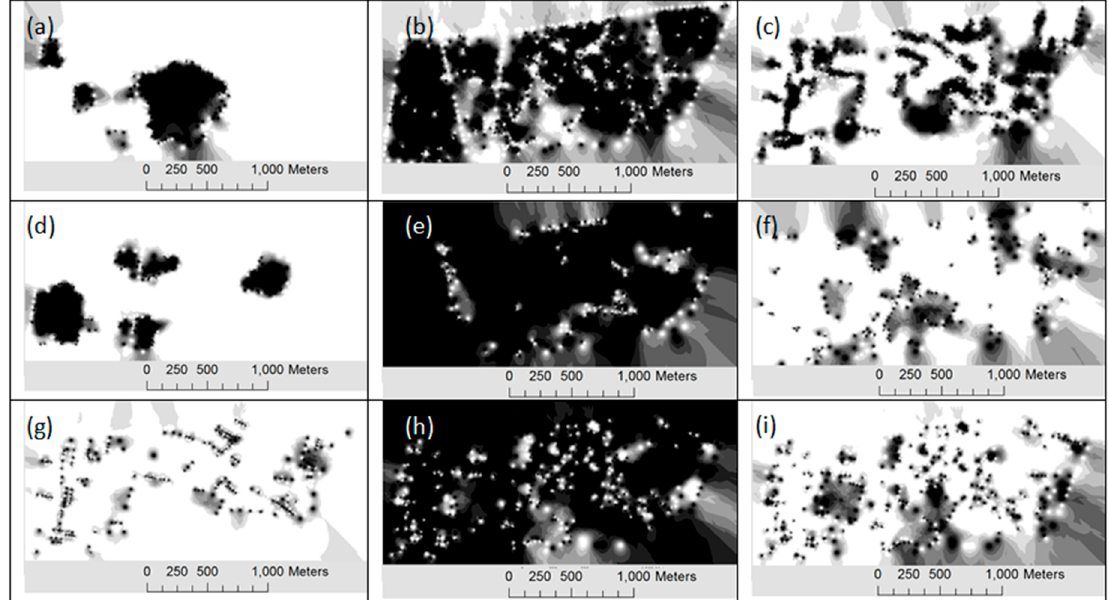
Figure 5. Parameters that denote legibility along the streets, that is, ( a ) singularity; ( b ) form simplicity; ( c ) continuity; ( d ) dominance; ( e ) clarity of joints; ( f ) directional differentiation; ( g ) visual scopes (determined by edges); ( h ) visual scopes (determined by paths); and ( i ) motion awareness.